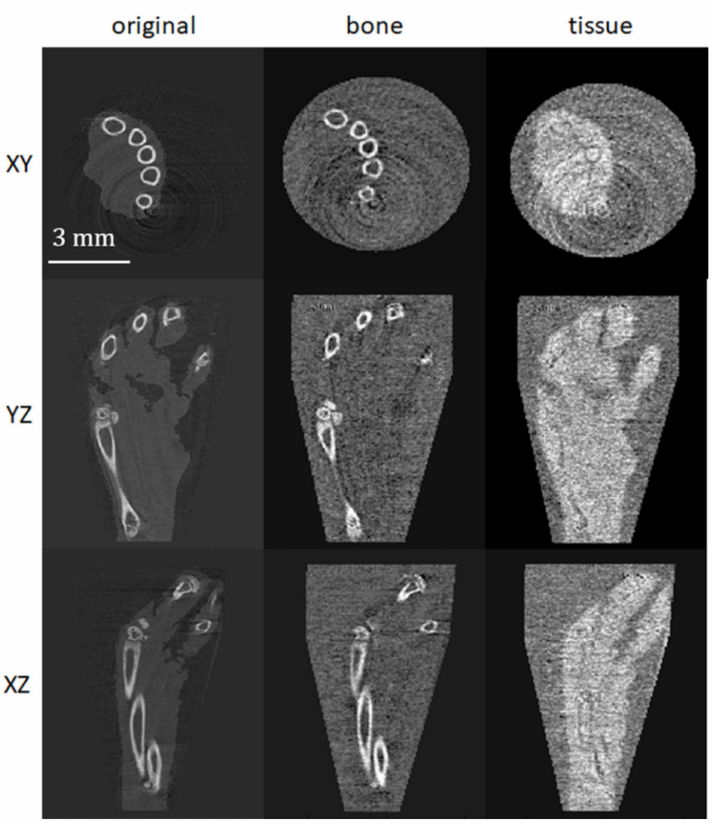
Figure 9. Tomographic reconstruction of the mouse hand. Left column: result corresponding to the 16 keV energy threshold. Middle column: retrieved thickness from bone and Right column: retrieved thickness from soft tissue after applying the matrix